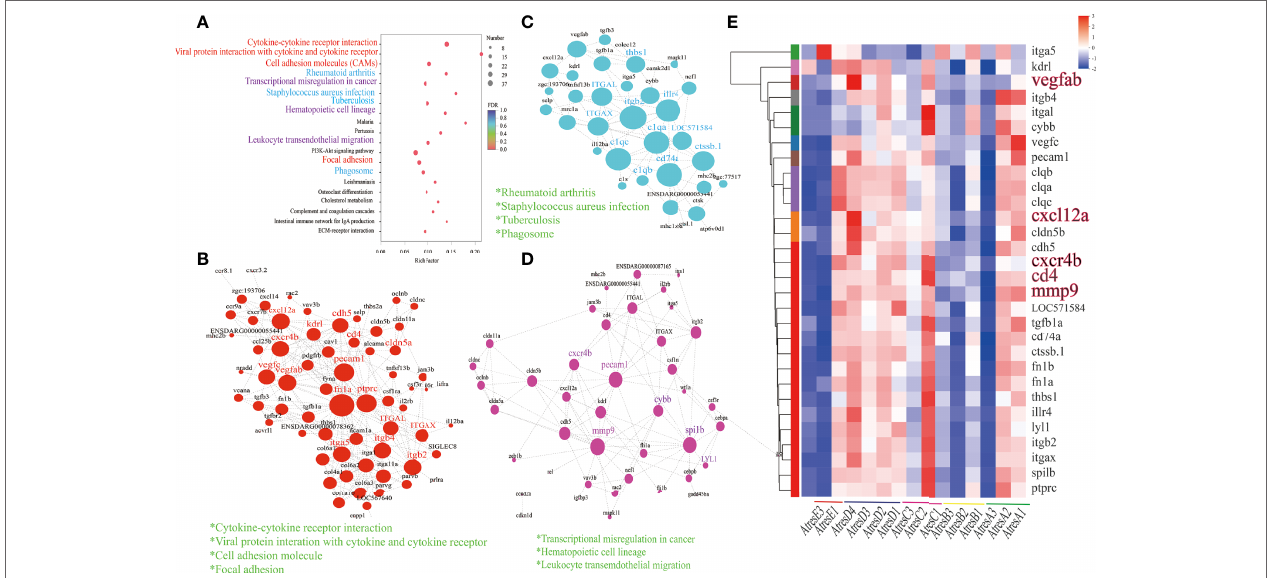
FIGURE 5 | Functions, dynamic changes, and protein–protein interaction networks of DEGs among AtresA, AtresB, AtresC, and AtresD compared with AtresE. (A) Kyoto Encyclopedia of Genes and Genomes (KEGG) pathway enrichment analysis. (B) protein–protein interaction networks of DEGs enriched in “cytokine-cytokine receptor interaction”, “viral protein interaction with cytokine and cytokine receptor”, “cell adhesion molecule”, and “focal adhesion” pathways. (C) Protein–protein interaction networks of DEGs enriched in “rheumatoid arthritis”, “staphylococcus aureus infection”, “tuberculosis”, and “phagosome” pathways. (D) Protein–protein interaction networks of DEGs enriched in “transcriptional misregulation in cancer”, “hematopoietic cell lineage”, and “leukocyte transemdothelial migration” pathways. (E) Hierarchical clustering and expression analysis of core